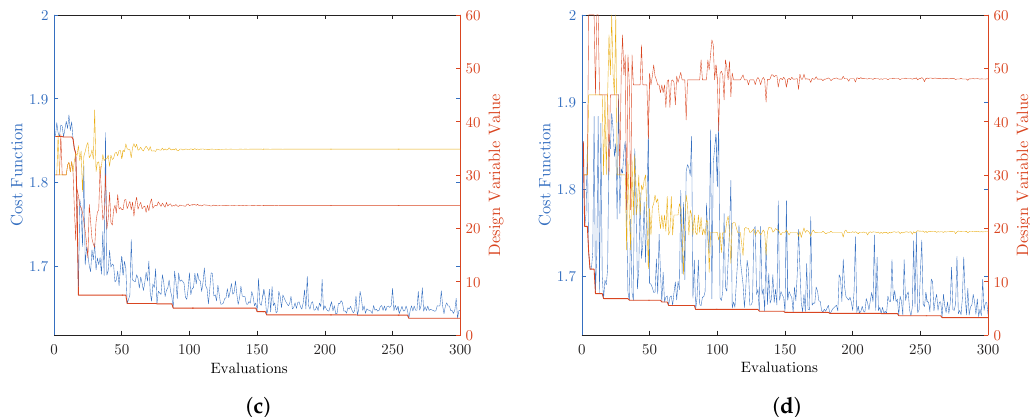
Figure 5. Evolution of the cost function and two design parameters during the design optimization process using ( a ) CMA-ES, ( b ) SDBOX, ( c ) Nelder–Mead, and ( d ) pattern search algorithms and a spline curve